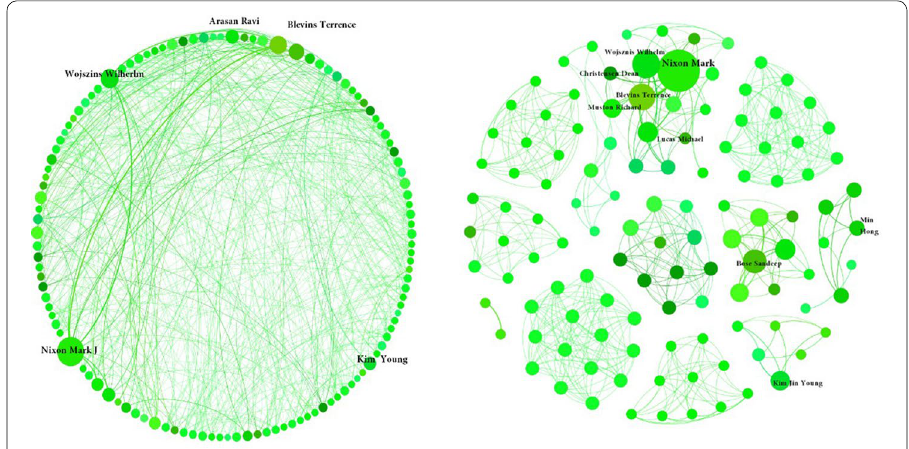
Fig. 14 Two layouts of the network of co-inventors of the major jurisdictions except